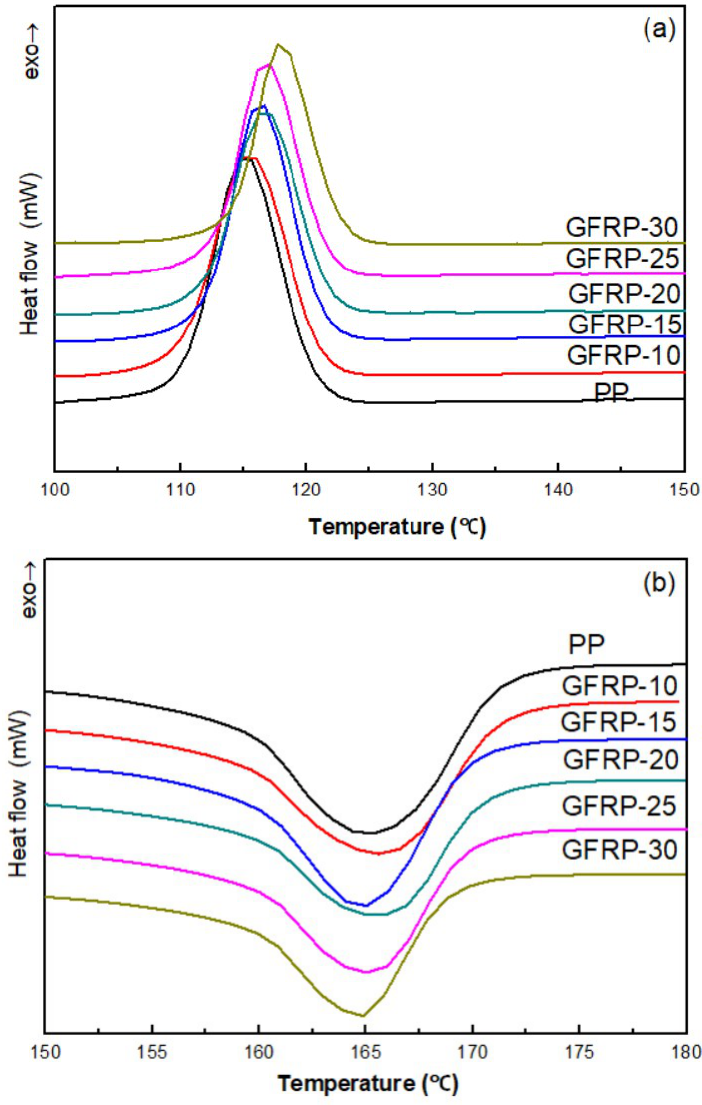
Figure 2. E ff ects of GF contents on the melting behavior and crystallization behavior of GFRP. ( a ) Di ff erential scanning calorimetry (DSC) curves of the crystallization behavior; ( b ) DSC curves of the melting